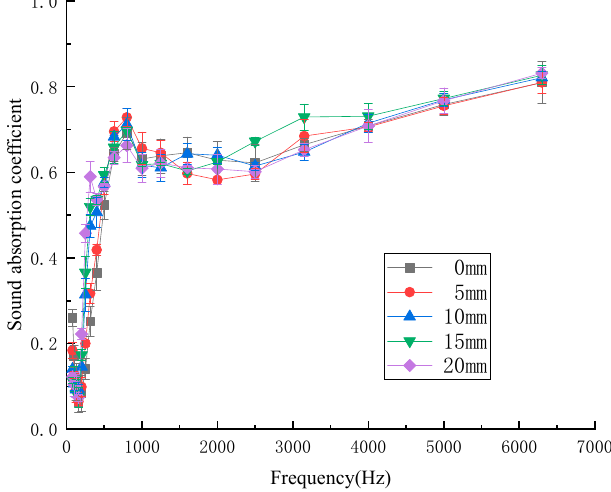
Figure 9. Sound-absorption coefficient with different air layer thicknesses.